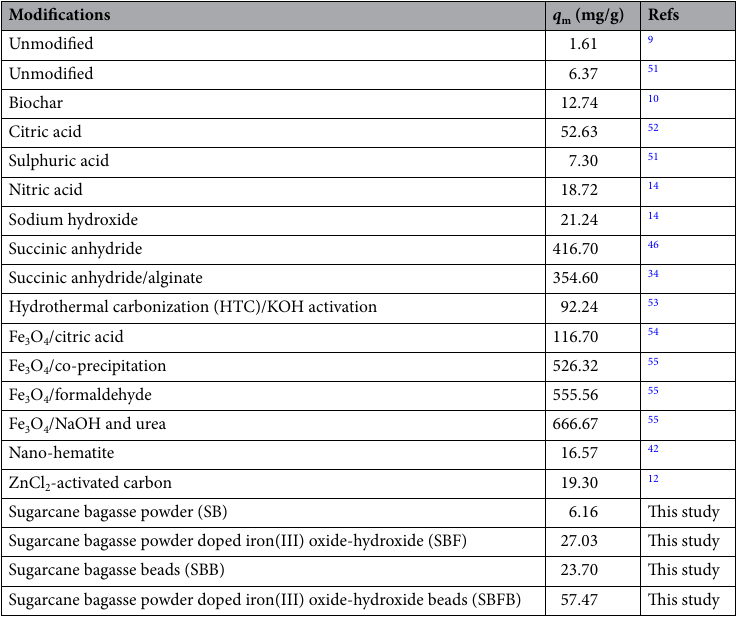
Table 4. Comparison of the maximum adsorption capacity for lead adsorption of various sugarcane bagasse